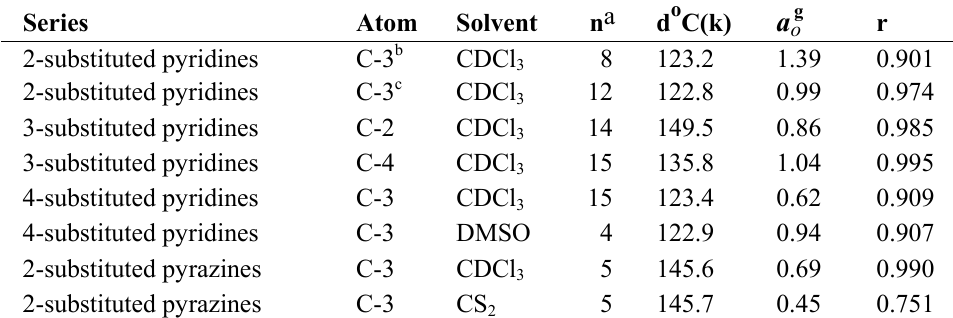
Table 2. Parameters of linear regressions (equation 3) of the chemical shifts of carbon atoms two bonds away from substituent with A